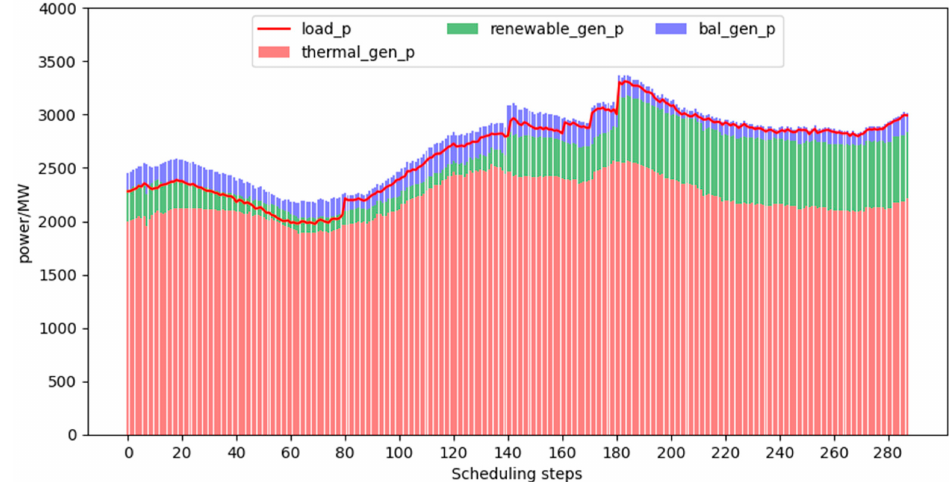
Figure 4. The scheduling period in which the total load is increasing.